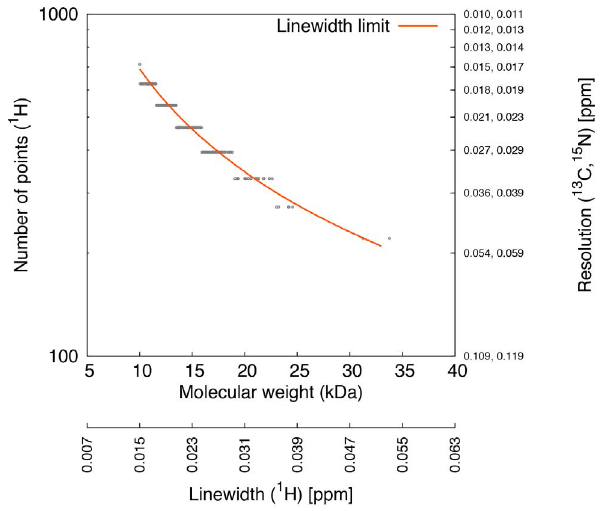
Figure 5. Adequate number of sampled data points as a function of the molecular weight. The adequate number of points is defined as the number of sampled points where the CSSO index stabilizes for the 13 C-resolved NOESY peaks. Each open circle represents one protein. The red line indicates the number of points where the resolution becomes smaller than the linewidth. The digital resolutions corresponding to the number of sampled points are on the right vertical axis. Calculated linewidths of the 1 H indirect dimension of 13 C- resolved NOESY peaks are shown below the horizontal axis. The adequate number of points for each protein (open circles) is taken from the numbers of points chosen for the calculations of Table S1.